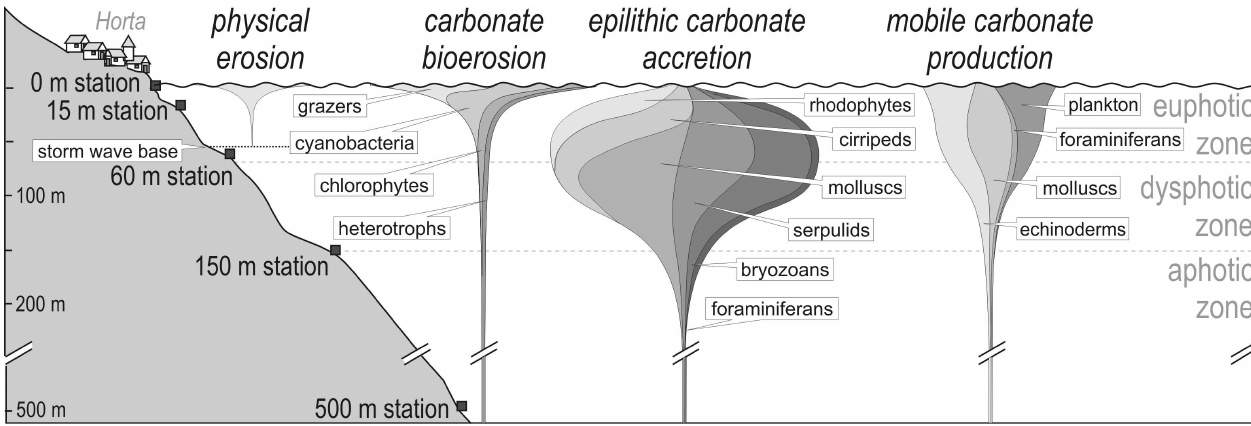
Fig. 8. Summary of processes as well as principal organism groups involved in carbonate production and degradation in the Azores carbonate C factory in relation to bathymetry, hydrodynamic force, and photic